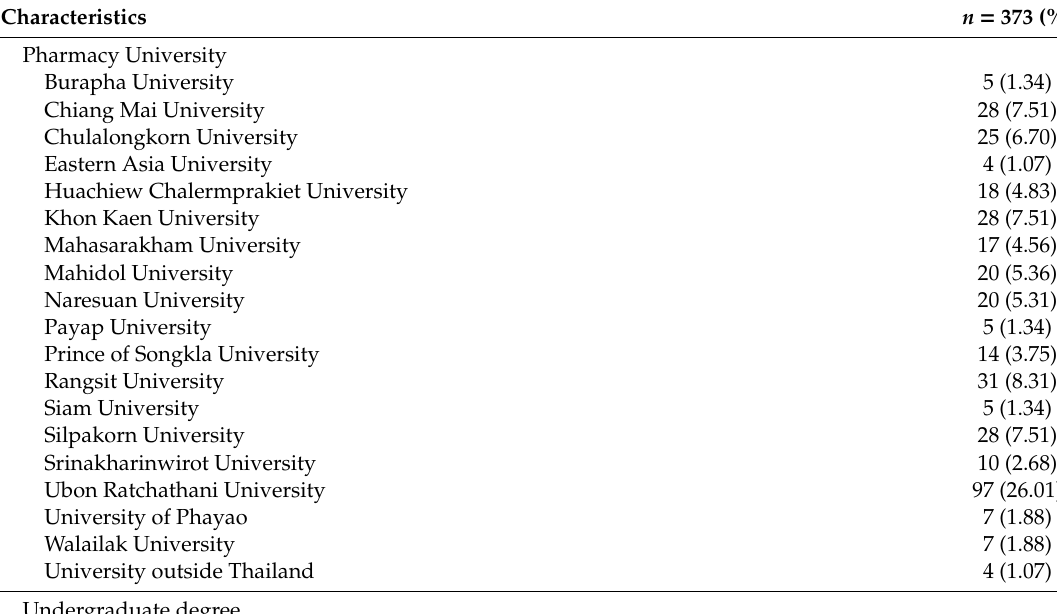
Table 4. Professional Background of the Participants.